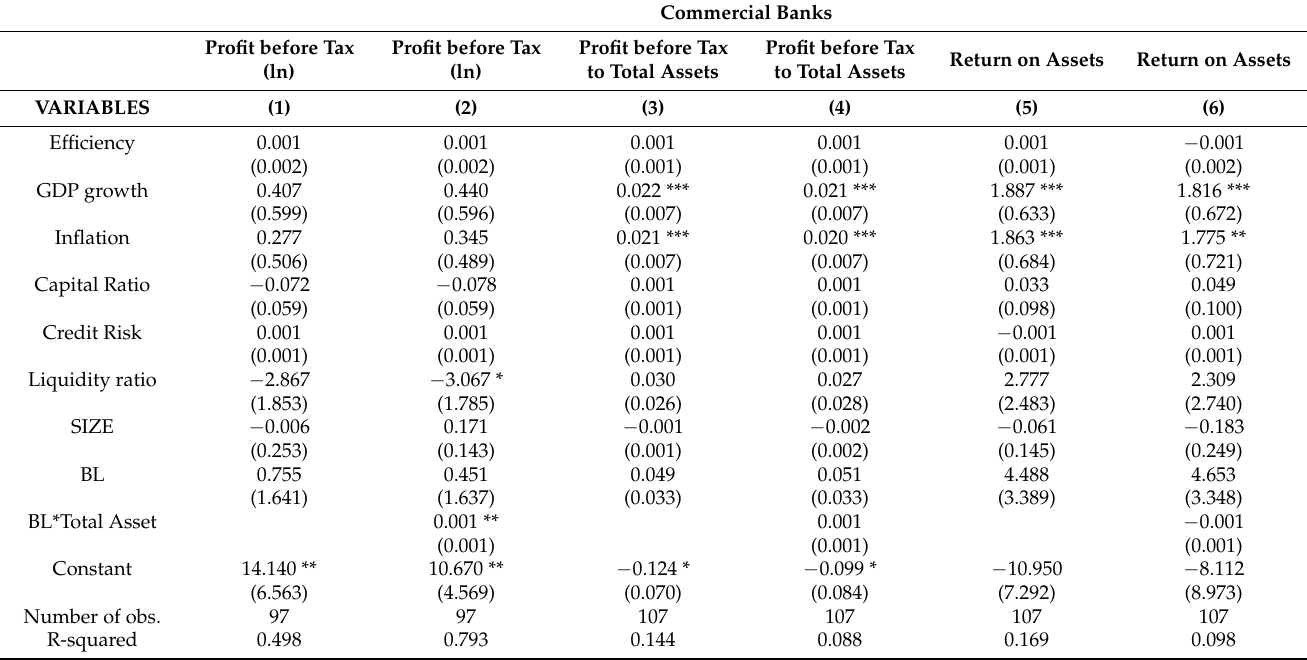
Table A1. Data presenting estimates based on GLS regressions with a random effect on Hungarian commercial banks. Symbols *, **, and *** represent statistical significance at the levels of 10%, 5%, and 1%,